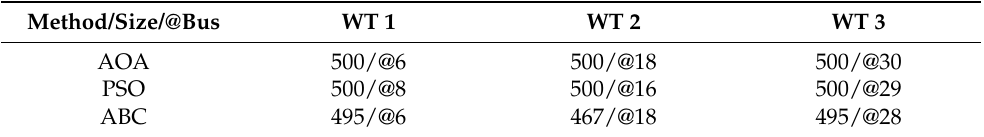
Table 5. Size and installation location of WTs in 33-bus distribution network using different methods.